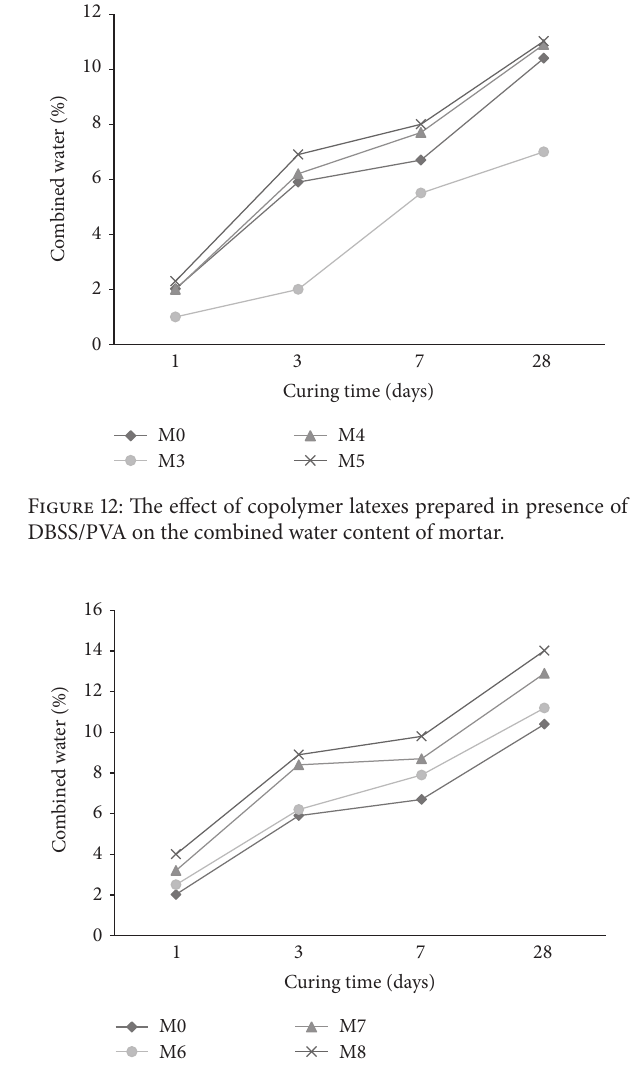
Figure 13: The effect of copolymer latexes prepared in presence of DBSS/POE on the combined water content of